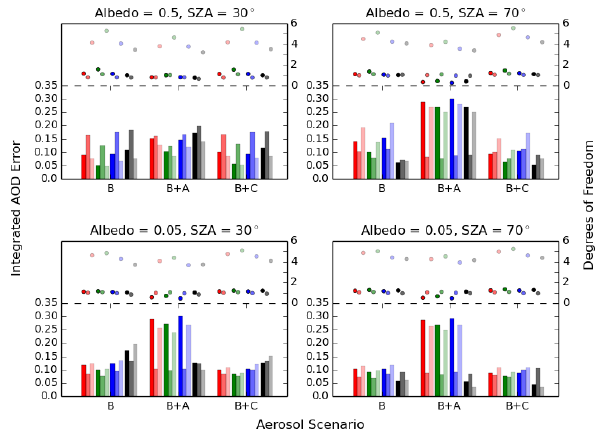
Figure 7. As Fig. 6 but for the aerosol scenario B and combined aerosol scenarios B + A and B + C. Note that scenario B + A is identical to A + B from Fig.